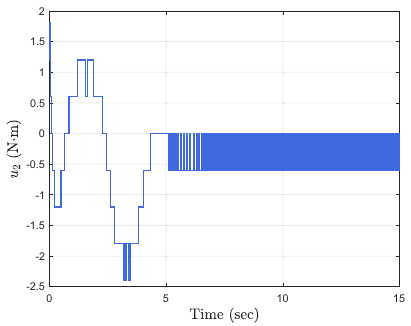
Figure 6. Event − triggered control input u 2 .